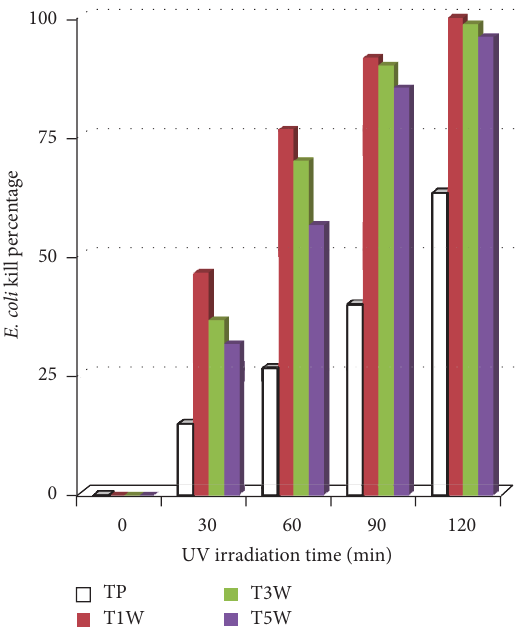
Figure 7: The E. coli kill percentage of WO 3 -doped TiO 2 coated